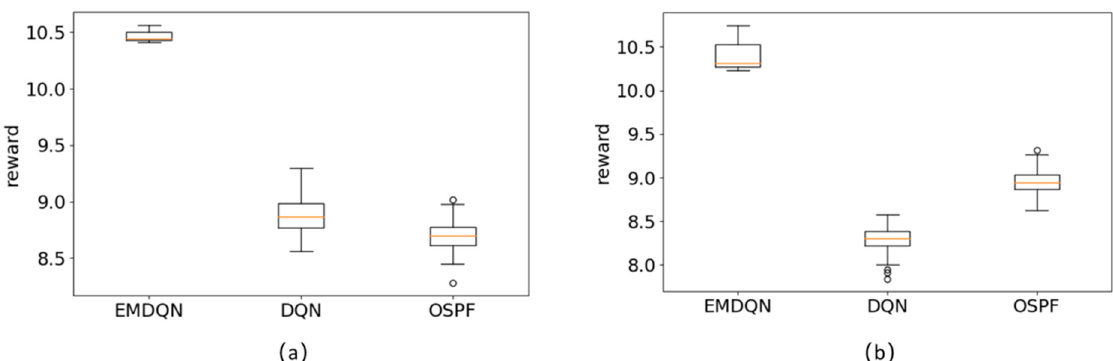
Figure 8. Performance of the algorithm after changing the network topology: ( a ) train in the NSFNET and evaluate in the GEANT2; ( b ) train in the NSFNET and evaluate in the GBN.